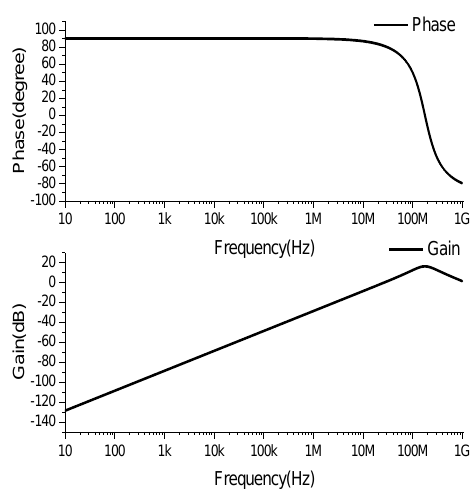
Figure 4. Frequency characteristic of coil.